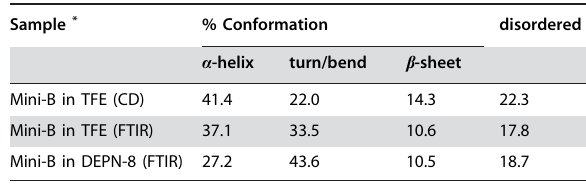
Table 1. Mean proportions of different aspects of secondary structure for Mini-B in structure-promoting TFE solvent or in deuterium-hydrated DEPN-8 multilayers based on CD and